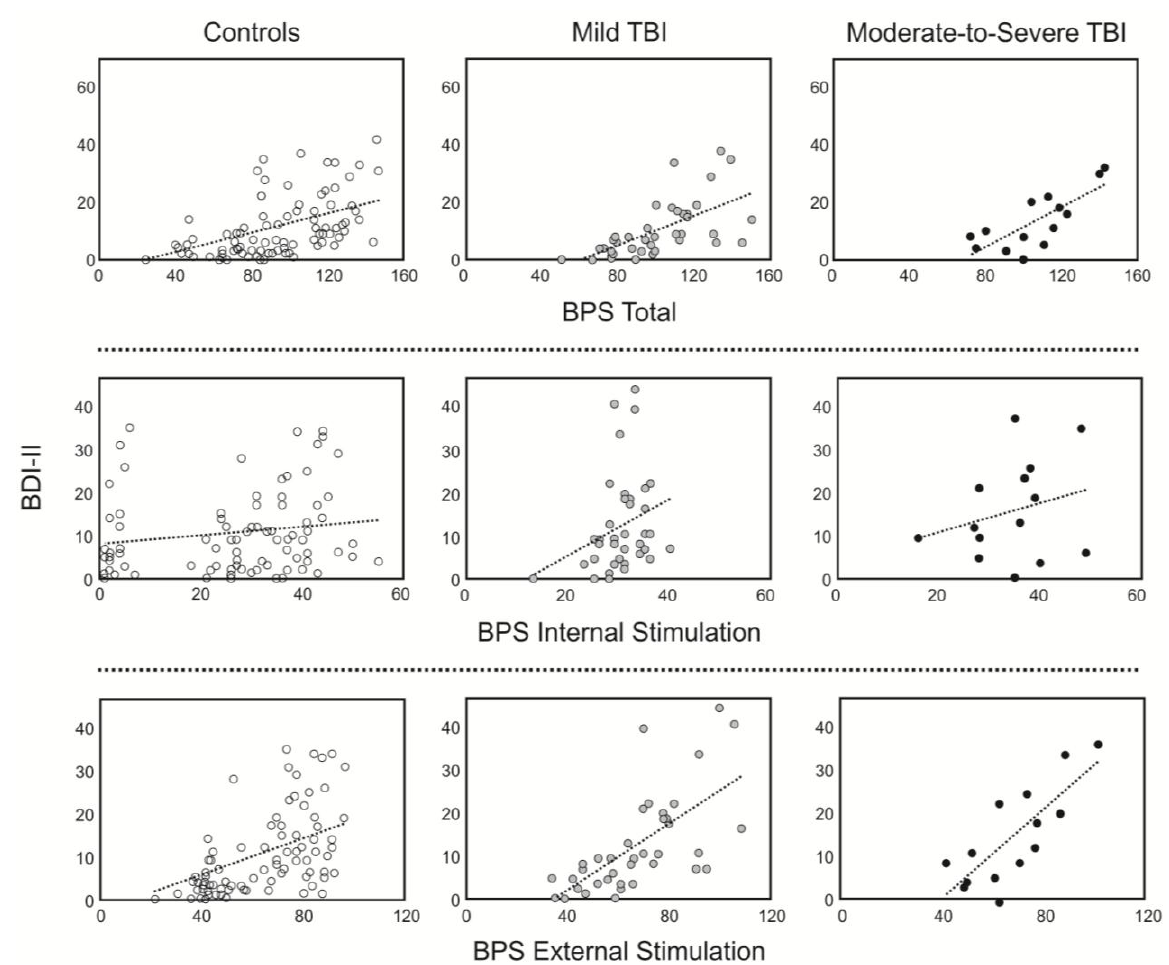
Figure 1. Scatterplots showing the relationship between the boredom proneness (BPS; x-axis) and depressive symptoms (BDI-II; y-axis). BDI-II = Beck Depression Inventory; BPS = Boredom Proneness